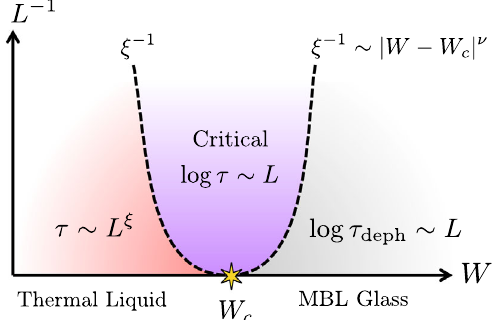
FIG. 1. Phase diagram and finite-size crossovers for one- dimensional many-body delocalization transitions. W parametr- izes disorder strength. For strong disorder W > W c , a nonergodic many-body localized glass is obtained, which lacks thermal transport but exhibits slow dephasing and entanglement dynam- ics with length-time scaling L ∼ log τ (where the subscript deph “ deph ” emphasizes that this is the dephasing time associated with virtual quantum fluctuations rather than the energy transport time scale, which is strictly infinite in the strong-disorder glass). Below a critical disorder strength W c , the MBL glass melts into a thermal, energy-conducting liquid. The melting transition is continuous (second order), characterized by a single diverging length scale ξ ∼ j W − W c j − ν , where ν ≈ 3 . 5 (cid:2) 0 . 3 . Energy trans- port (entanglement spreading) in the thermal liquid is charac- terized by a subdiffusive (sub-ballistic) power-law scaling between time and length τ ∼ L z , with dynamical exponent z ∼ ξ that diverges continuously upon approaching the